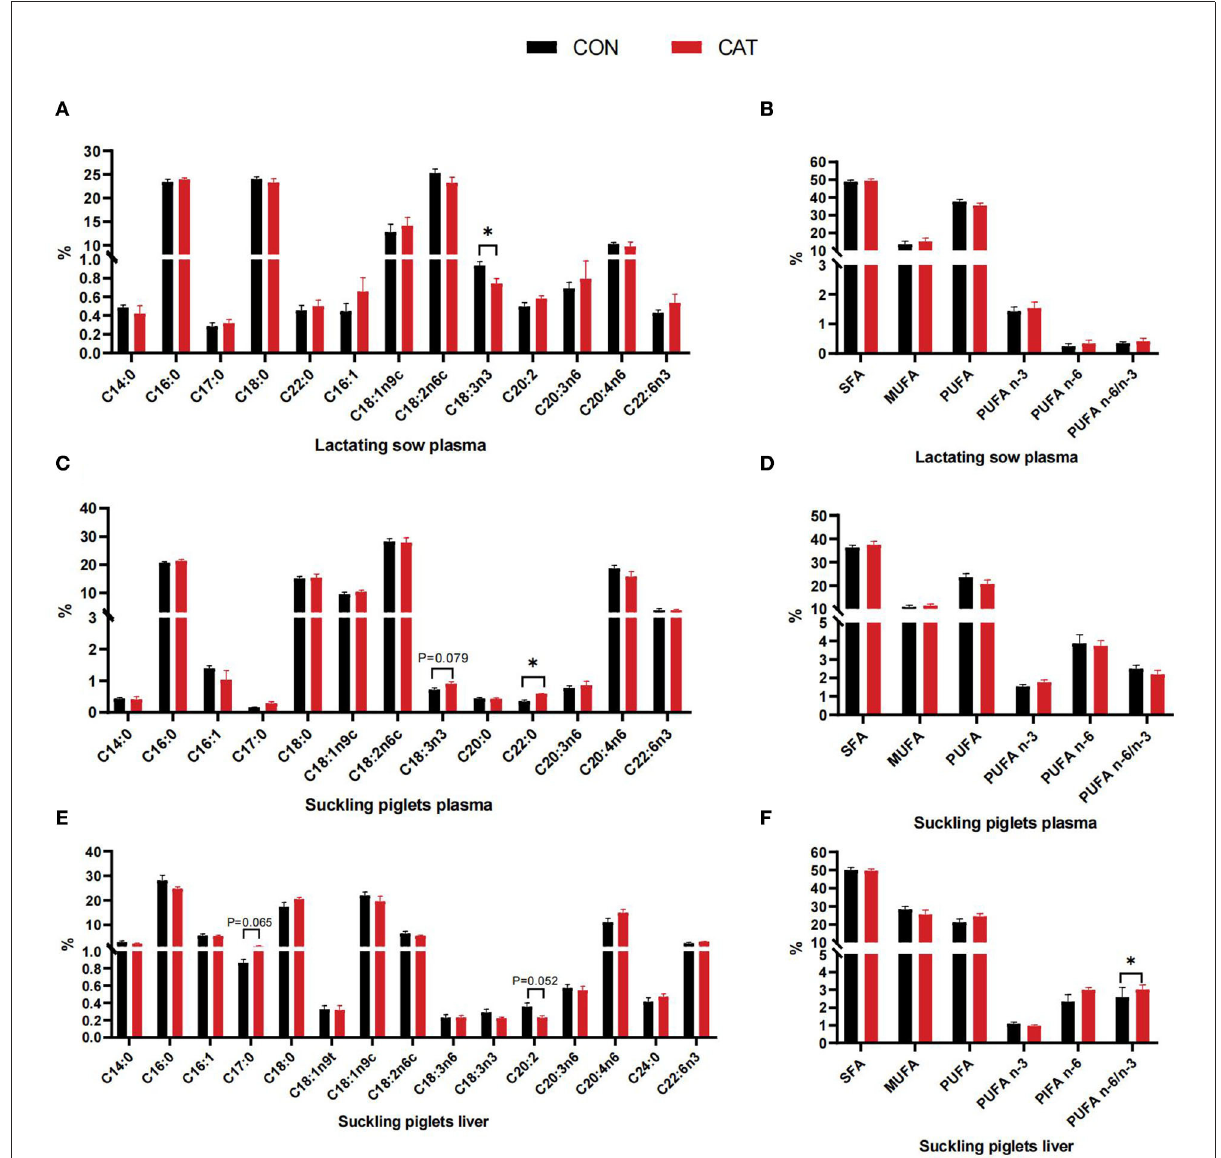
FIGURE3 (A–F) Plasma and hepatic fatty acid profiles of lactating sows and suckling piglets. Values are presented as mean ± SEM; SFA, saturated fatty acid (including C14:0, C16:0, C17:0, C18:0, C20:0, and C22:0); MUFA, monounsaturated fatty acids (including C16:1, C18:1n9t, C18:1n9c, and C20:1); PUFA, polyunsaturated fatty acids (including C18:2n6c, C18:3n3, C20:3n6, C20:4n6, and C22:6n3); *indicate a statistically significant difference by t -test at P <